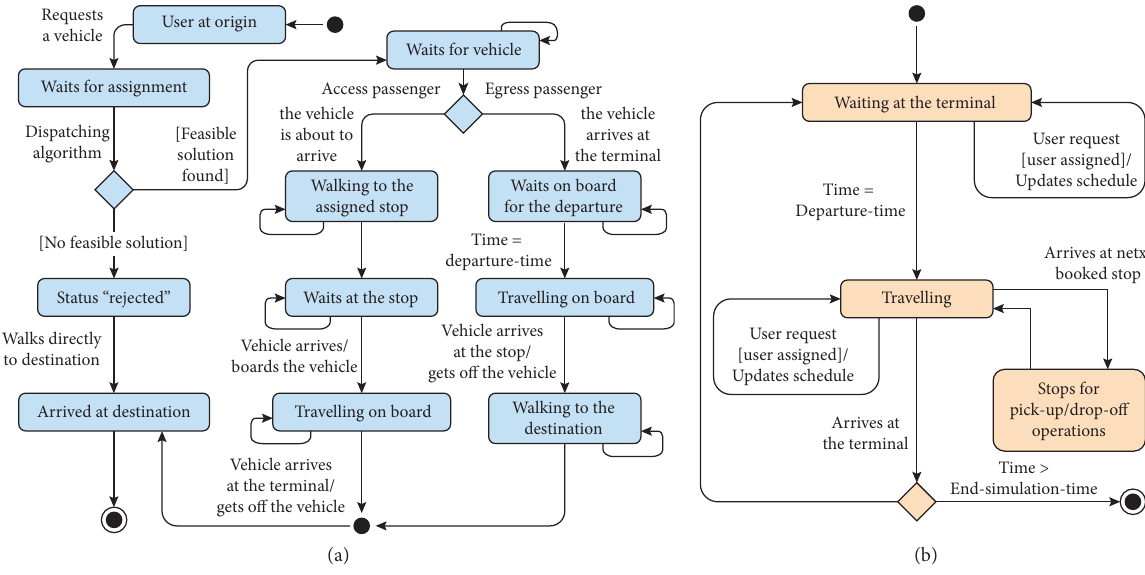
Figure 4: State charts for the DRF feeder service: (a) passenger state chart and (b) vehicle state